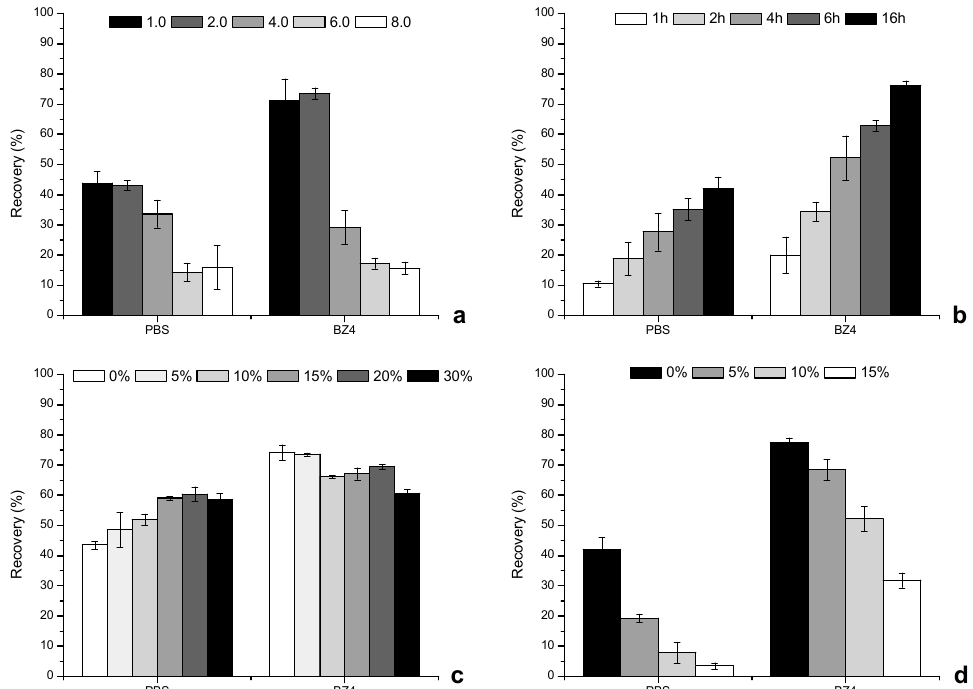
Figure 2. Effect of pH ( a ), equilibrium time ( b ), ionic strength ( c ), and matrix polarity ( d ) on the microextraction e ffi ciency for both UV filters in ultra-pure water. The error bars represent the standard microextraction efficiency for both UV filters in ultra ‐ pure water. The error bars represent the deviation of three replicates. standard deviation of three replicates.